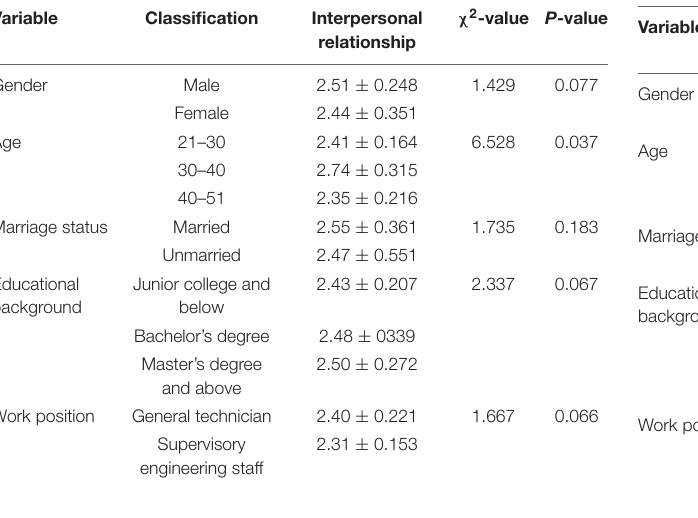
TABLE 4 | Differences in stress values of interpersonal relationship under various demographic